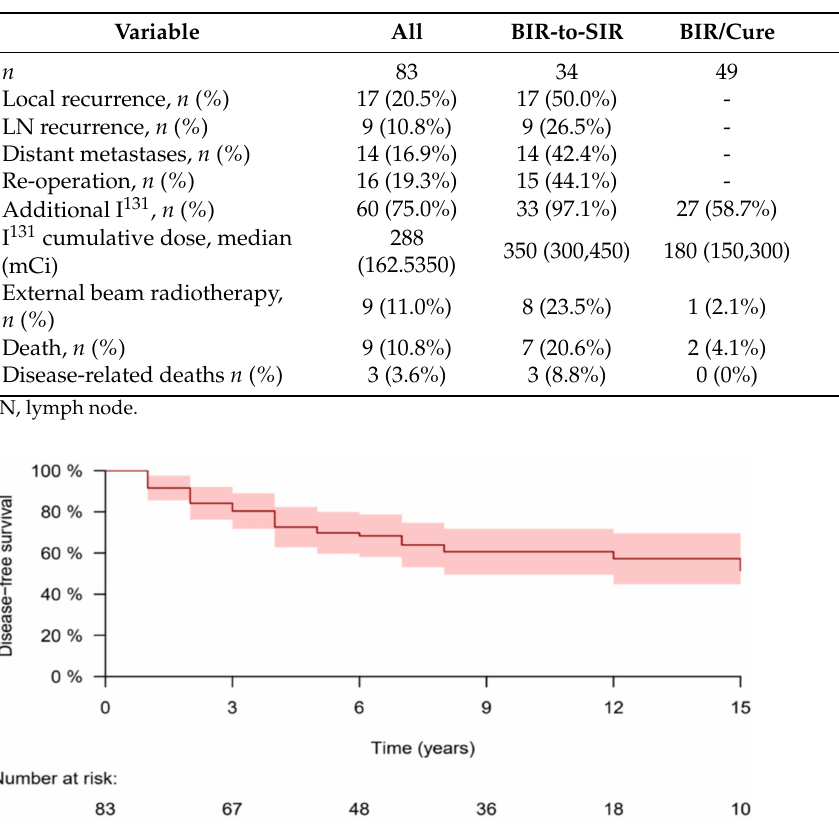
Figure 1. Overall disease-free survival for biochemically persistent DTC